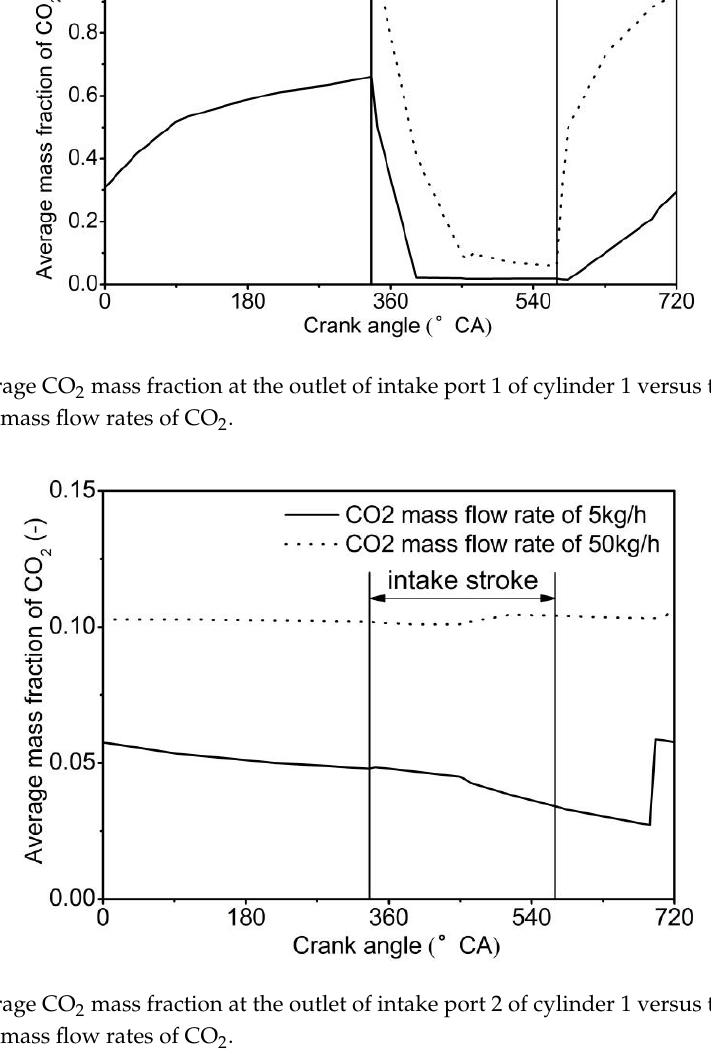
Figure 9. Average CO 2 mass fraction at the outlet of intake port 2 of cylinder 1 versus the crank angle with different mass flow rates of CO 2 .